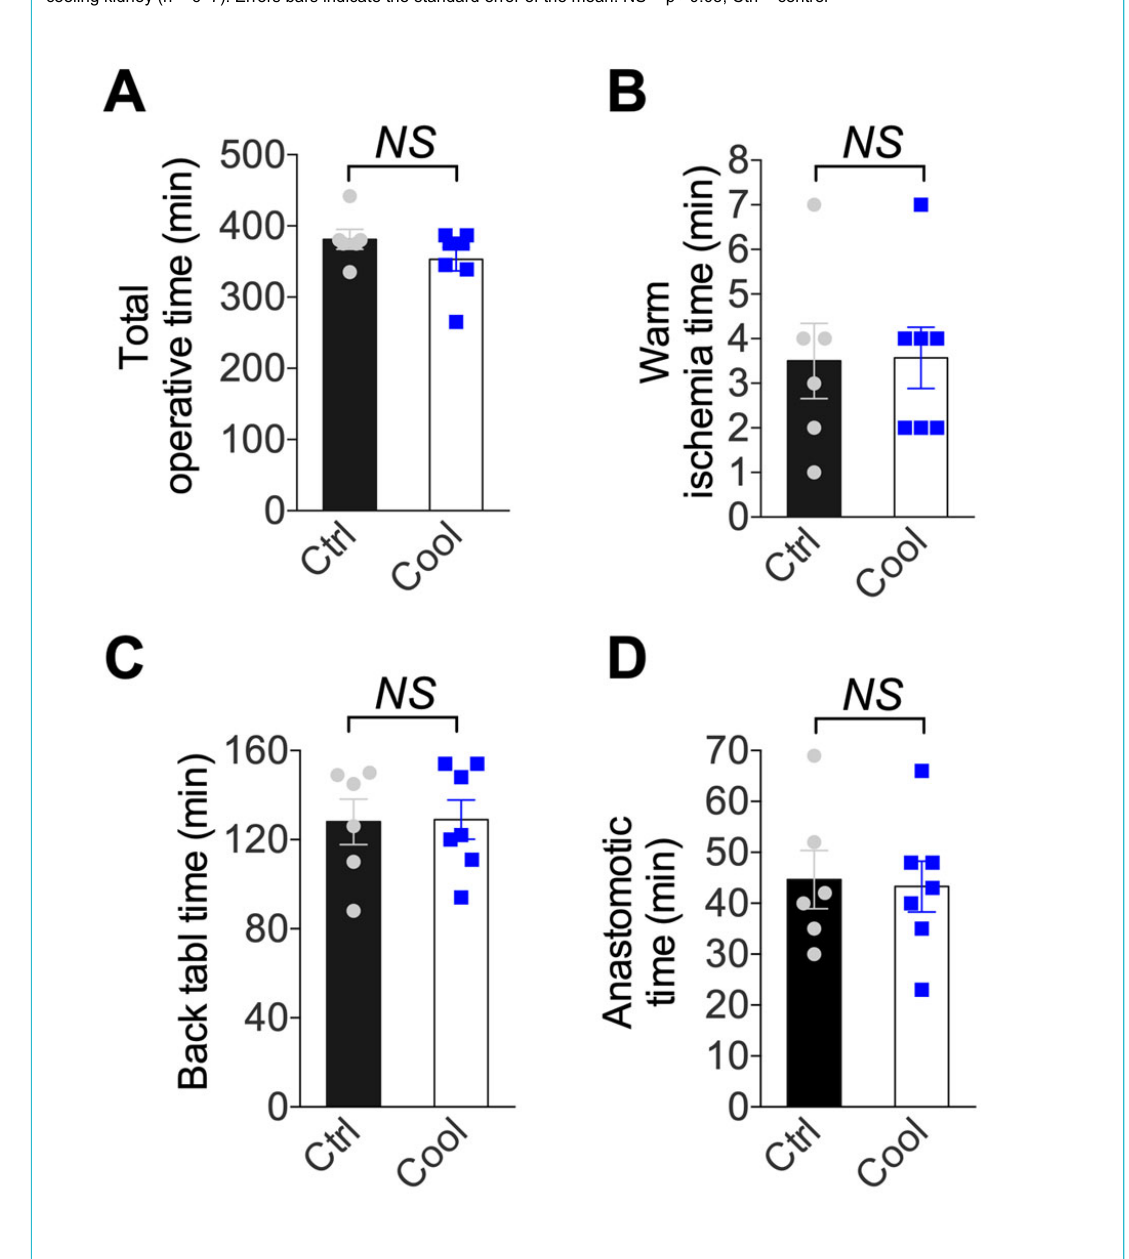
Figure 3: Intra-operative data. (A) Total operative time, (B) warm ischaemia time, (C) back table time, (D) anastomotic time from control and cooling kidney (n = 6–7). Errors bars indicate the standard error of the mean. NS = p >0.05; Ctrl =